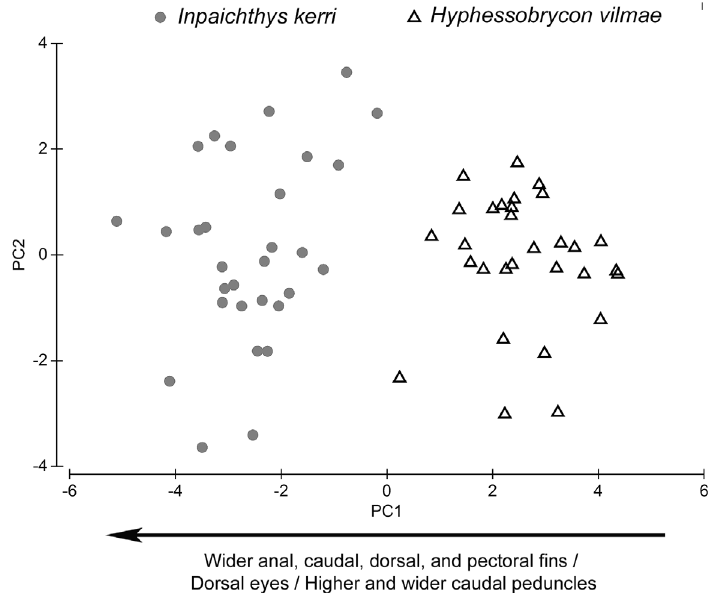
FIGURE 3 | Biplot resulting from the principal component analysis (PCA) from ecomorphological data, showing the position of 30 individuals of Inpaichthys kerri and 30 of Hyphessobrycon vilmae in the ecomorphological space, represented by the two first axis (PC1 and PC2) and analyzed from 22 ecomorphological attributes. Arrow indicates the variation of the most important attributes (see Tab. 2). TABLE 2 | Abbreviation and Pearson correlation values obtained for each ecomorphological attributes in the two first axis (PC1 and PC2) of the principal component analysis (PCA). Values > 0.7 are in bold because they explained the most the ecomorphological pattern for both